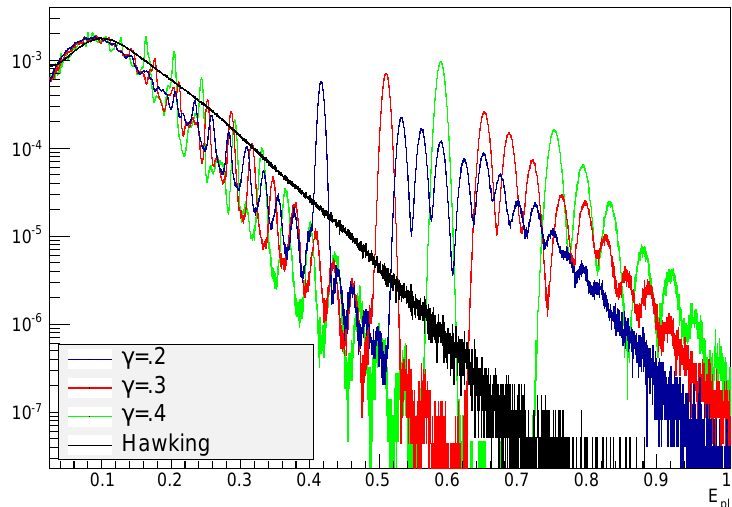
Figure 3. γ dependence of the integrated spectrum, as function of the energy of the emitted particle, in the holographic model, with a detector energy resolution of 5%. From